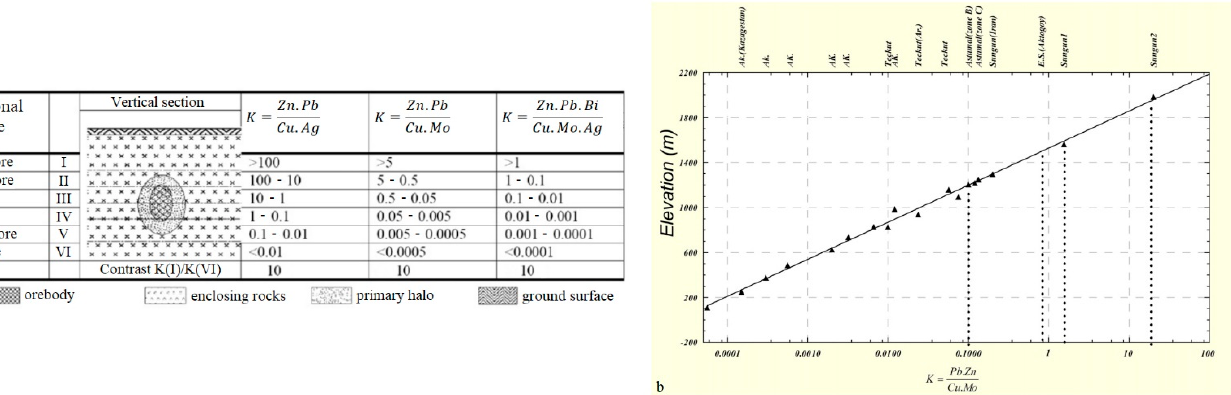
Figure 5. ( a ) Vertical geochemical zonality models for porphyry-Cu deposits based on typical standard porphyry-Cu deposits in Kazakhstan, Bulgaria, Armenia, and Iran (modified after Reference [71]); ( b ) geochemical model for porphyry-Cu deposit based on the porphyry Cu deposits database comprising Aktogy (Kazakhstan), Asarel (Bulgaria), Tekhut (Armenia), and Sungun (Iran) (modified after Reference [2]).